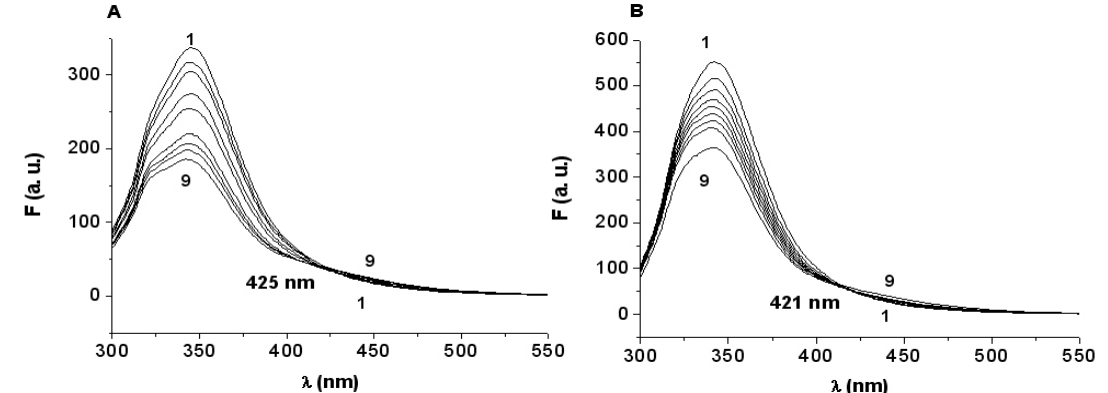
Figure 2. Emission spectra of A) [HSA] = 0.75×10 -6 M, λ 1–9: d/p = 0; 0.44; 1.31; 1.73; 2.99; 3.40; 4.61; 6.17; 8.03; pH 7.4, T=298 K.